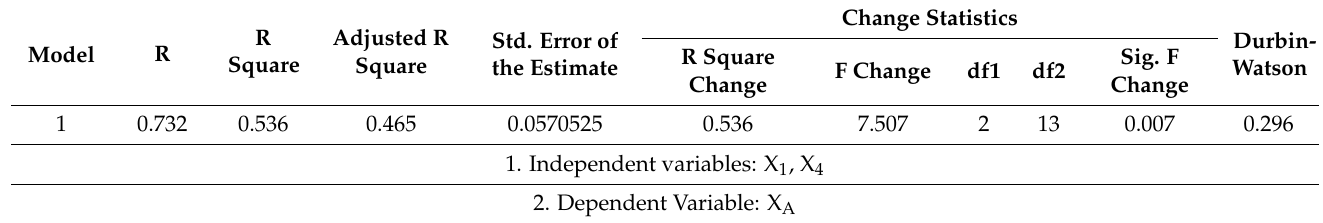
Table 11. Model summary with two